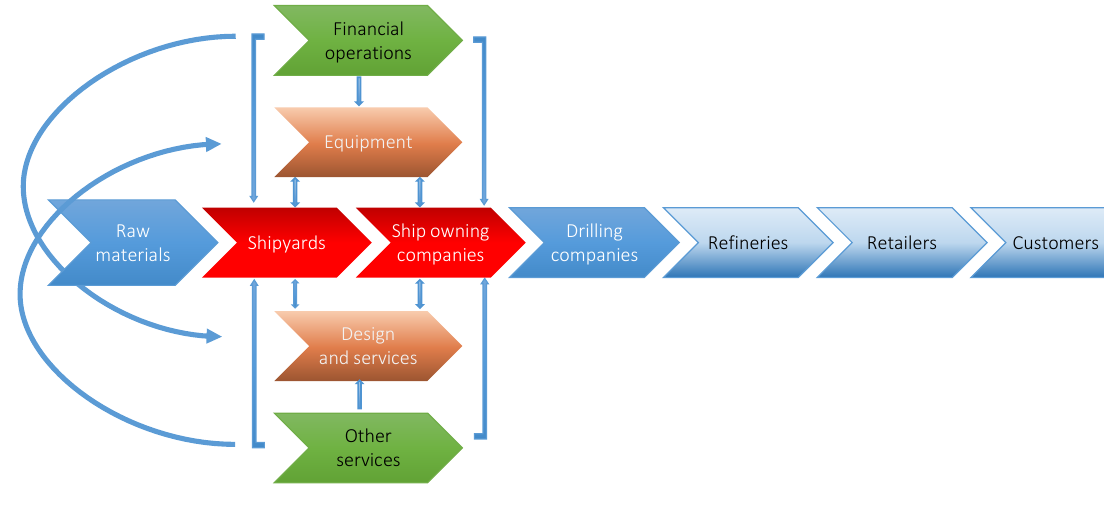
Figure 3. Supply chain related to